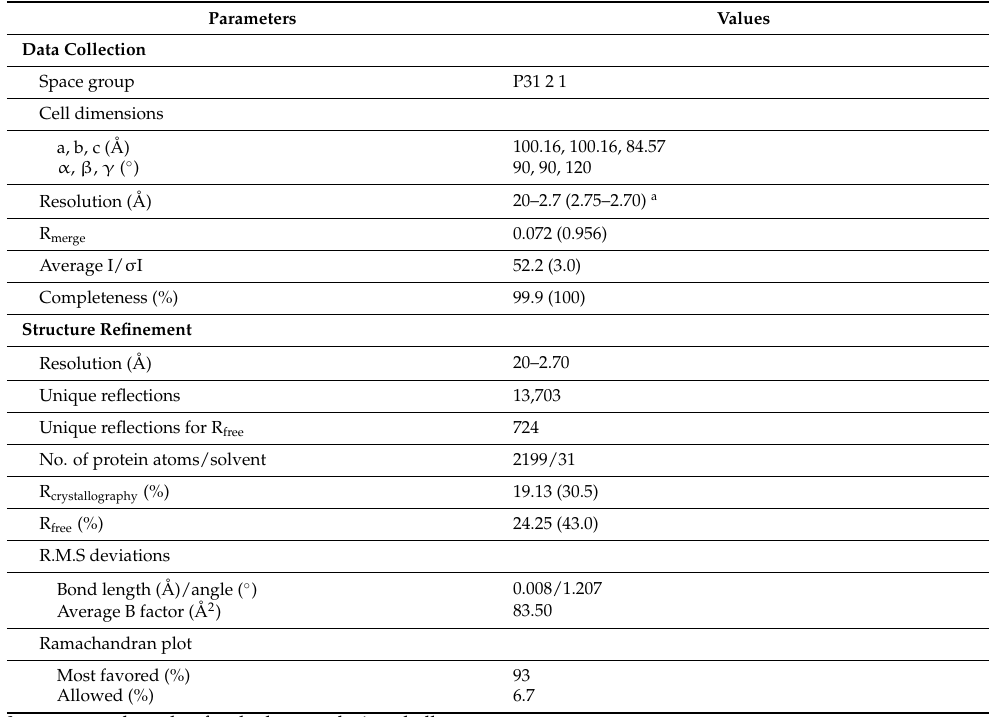
Table 1. Data collection and Structure refinement